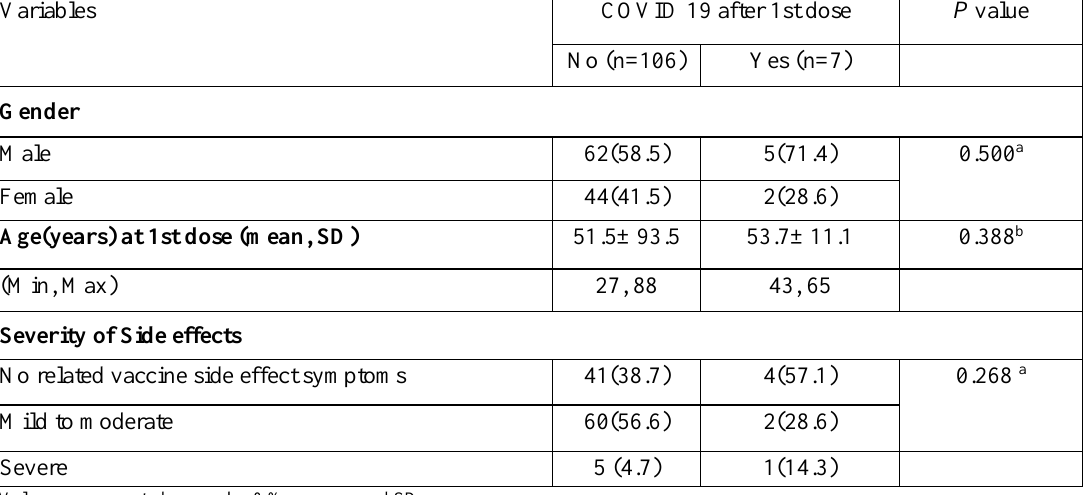
Table 3. Distribution of vaccinated staff according to COVID-19 infection status.